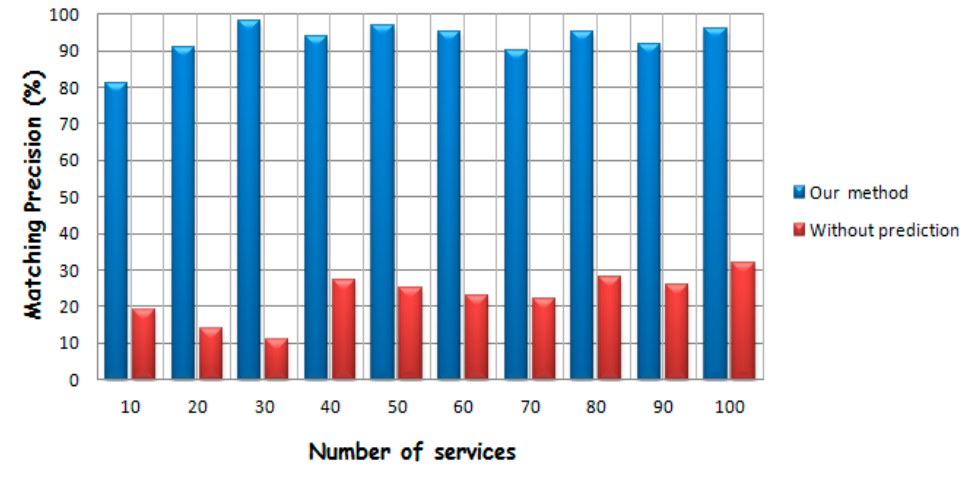
Figure 22. Services matching precision with/without the prediction strategy.